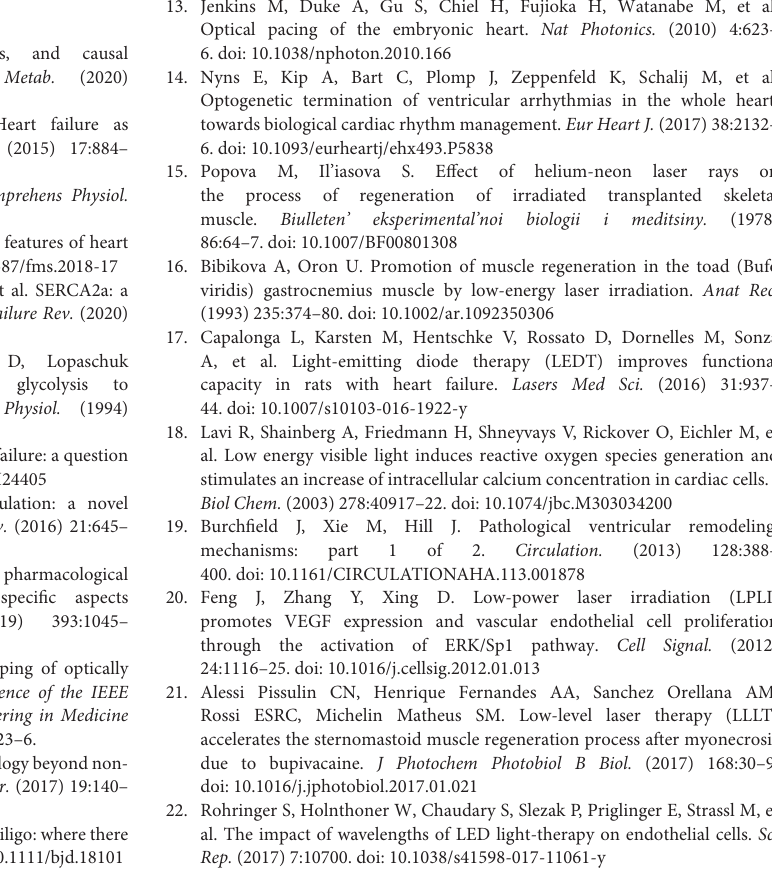
Supplementary Figure 1 | 630nm LED-Red is the appropriate wavelength range for treating heart failure. (A) Cardiac function by echocardiography. Ejection fraction, EF. Fractional shortening, FS. n = 3, ∗∗∗ P < 0.001 vs. Sham, ## P < 0.01 vs. HF. Data are expressed as the mean ±